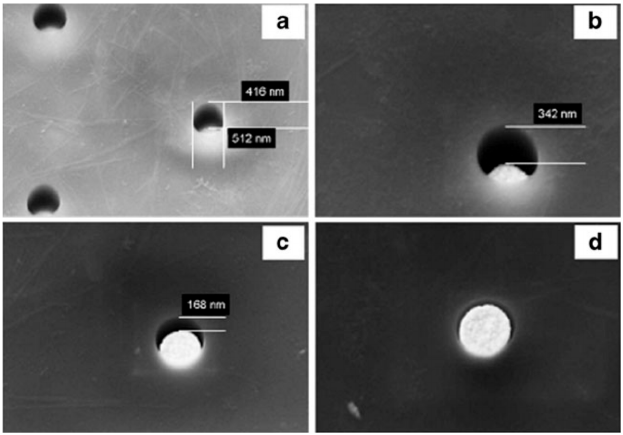
Figure 7. SEM images of NEAs with holes 500 nm in diameter with gold electrochemically deposited inside for 0 s ( a ); 10 s ( b ); 20 s ( c ); and 30 s ( d ). Estimated recession depths: ( a ) 450 nm; ( b ) 300 nm; ( c ) 150 nm; ( d ) 0 nm (reprinted with permission from [68]).